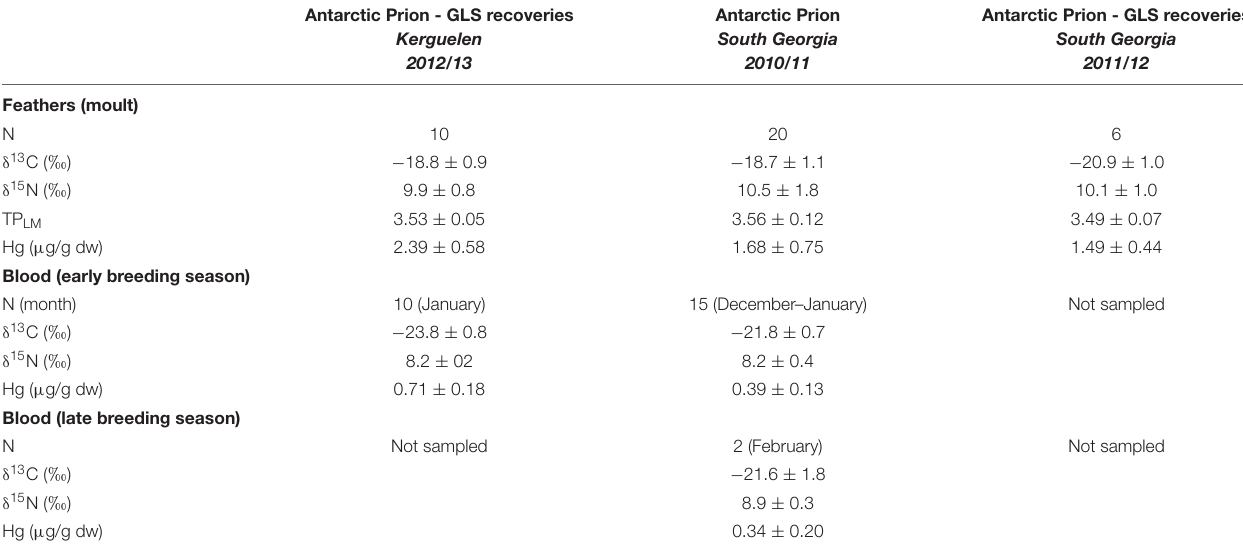
TABLE 3 | Summary of stable isotope and mercury data of Antarctic Prions (mean ± standard deviation), as well as trophic position (TP) estimates based on linear models (TP LM